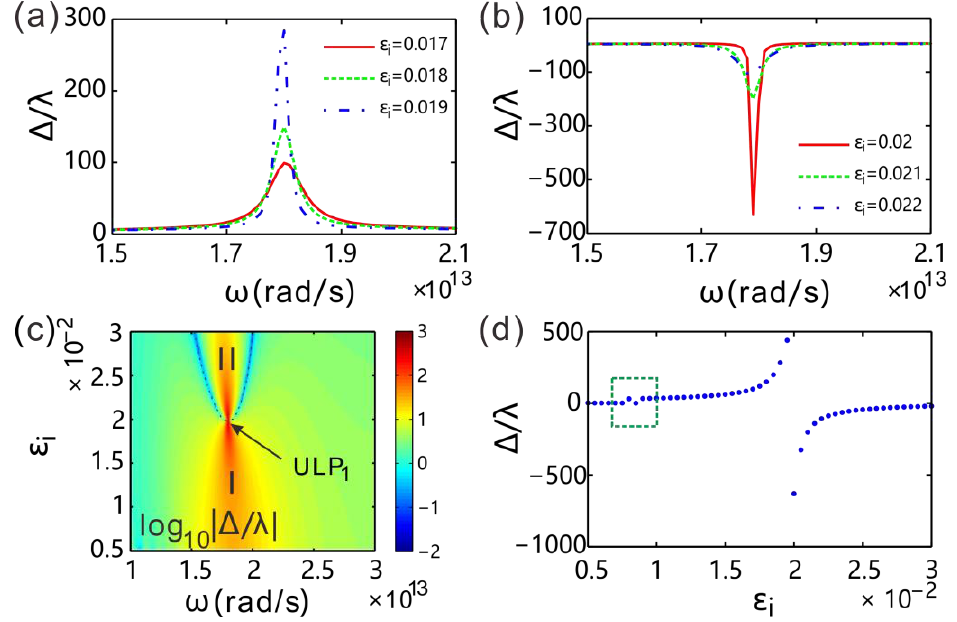
Figure 6. ( a,b ) The lateral shift of reflected light versus the angular frequency for several permittivities around ULP 1. The permittivity ε i < ε i 1 for ( a ) and ε i > ε i 1 for ( b ). ( c ) The lateral shift of reflected light in the vicinity of ULP 1 . The lateral shift was positive in part I, while it was negative in part II. The results were rescaled by taking logarithm log 10 | ∆/λ | for clarity. ( d ) The maximum lateral shift of reflected light varying with the permittivity around ULP 1 .